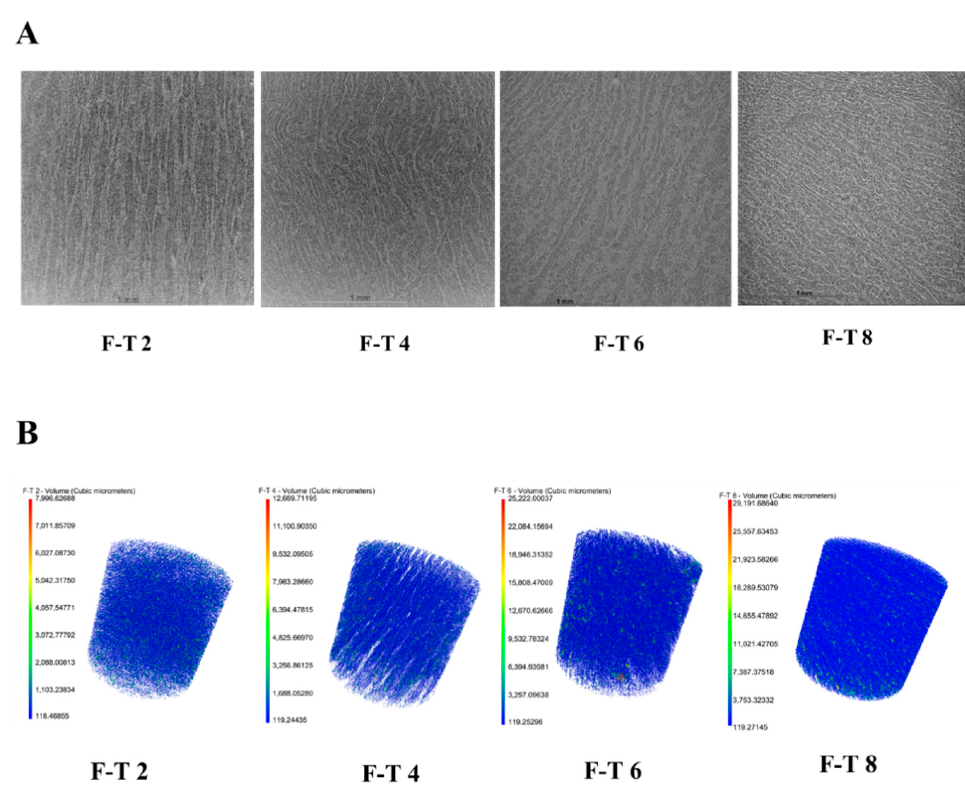
Figure 5. The microstructure ( A ) and the porosities of pore ( B ) of the samples in varying freeze–thaw (F–T) cycles by uCT. Pores are shown in blue colour, resulting in the obvious decreases in total and active sulfhydryl content.